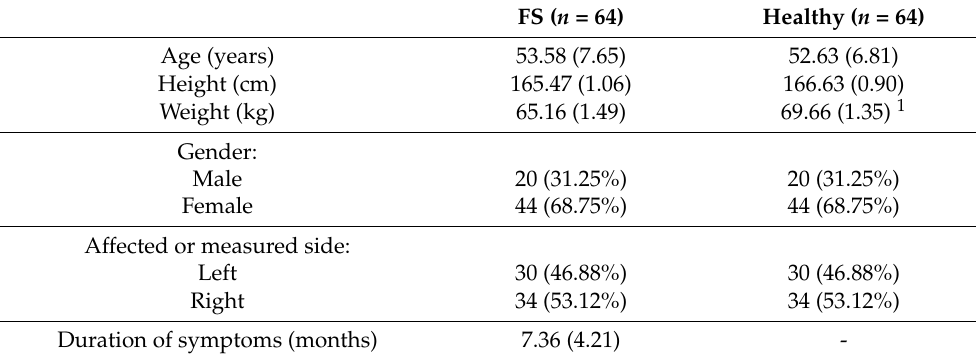
Table 1. Basal descriptive data.